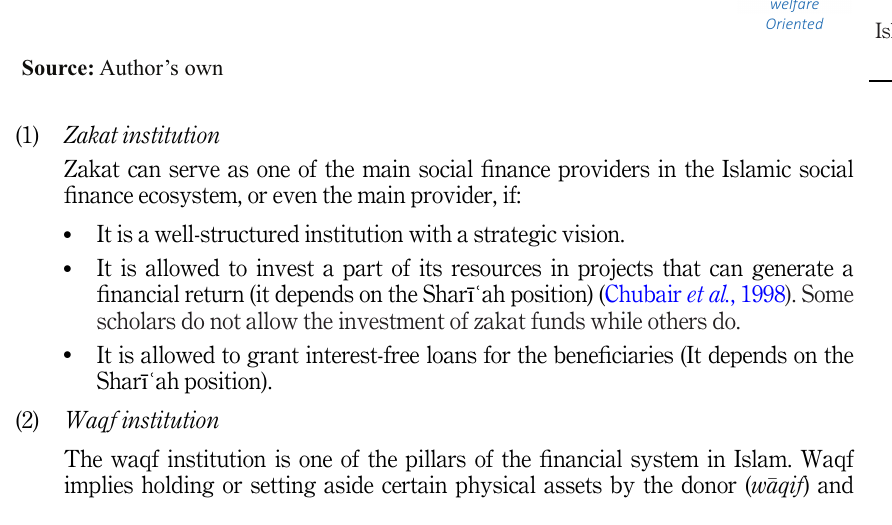
Figure 2. Social welfare initiators in an Islamic social fi nance